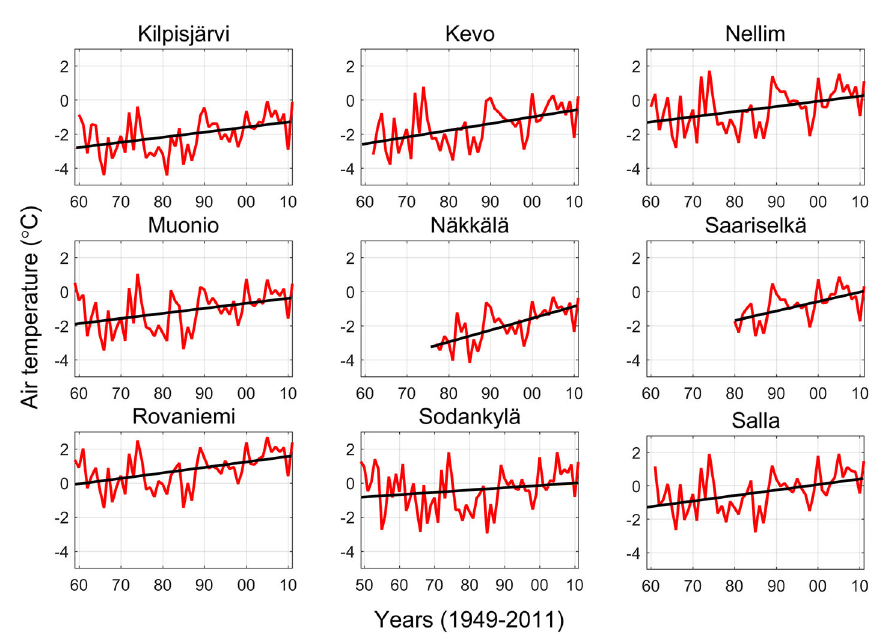
Fig. 3. Long-term variations in mean annual air temperature at the Lapland